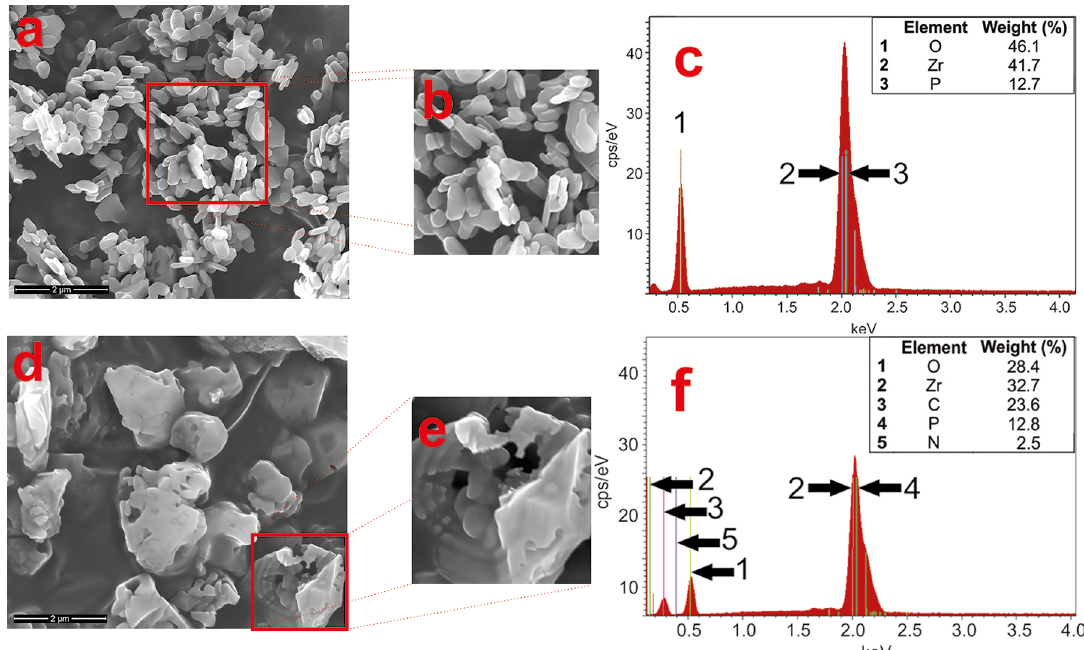
Figure 6. (a) and (d) EDX spectra of ZrP and E-A/ZrP; (b), (c), (e) and (f) SEM micrographs of ZrP and